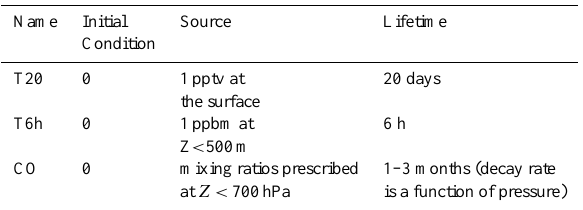
Table 2. The idealised tracers used in the experiments More details are provided in the text.